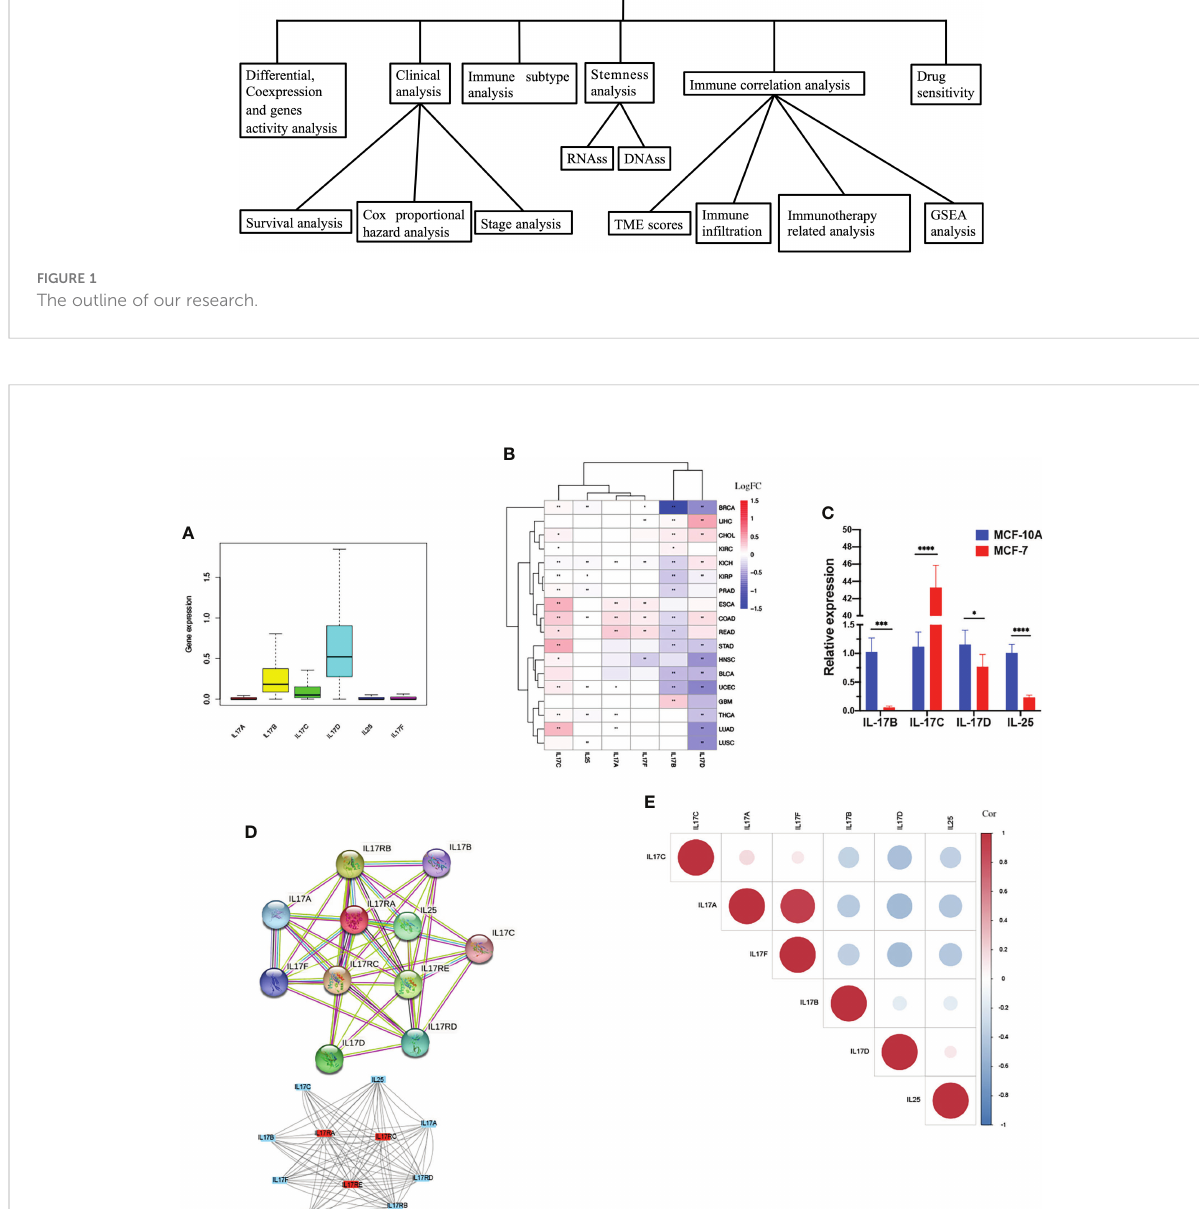
FIGURE 2 Differential expression analysis. (A) The box plot showing the transcriptional expression levels of the IL-17 family based on the TCGA dataset. (B) The heatmap exhibiting the transcriptional level of the IL-17 family in TCGA tumor types compared to adjacent normal tissues; the gradient colors represent the log fold change (logFC) value. (Red points indicate high expression, while blue points indicate low expression.) (C) Level of IL-17B, IL-17C, IL-17D, and IL-25 (IL-17E) mRNA in MCF-10A and MCF-7. (D) The protein – protein interaction (PPI) network constructed among IL-17A, IL-17B, IL-17C, IL-17D, IL-25, IL-17F, and their receptors. The core gene was marked red. (E) Co-expression analysis between each two genes is presented. (Red points indicate positive correlation, while blue points indicate negative correlation.) ( ∗∗∗∗ p < 0.0001; ∗∗∗ p < 0.001; ∗∗ p < 0.01; ∗ p <